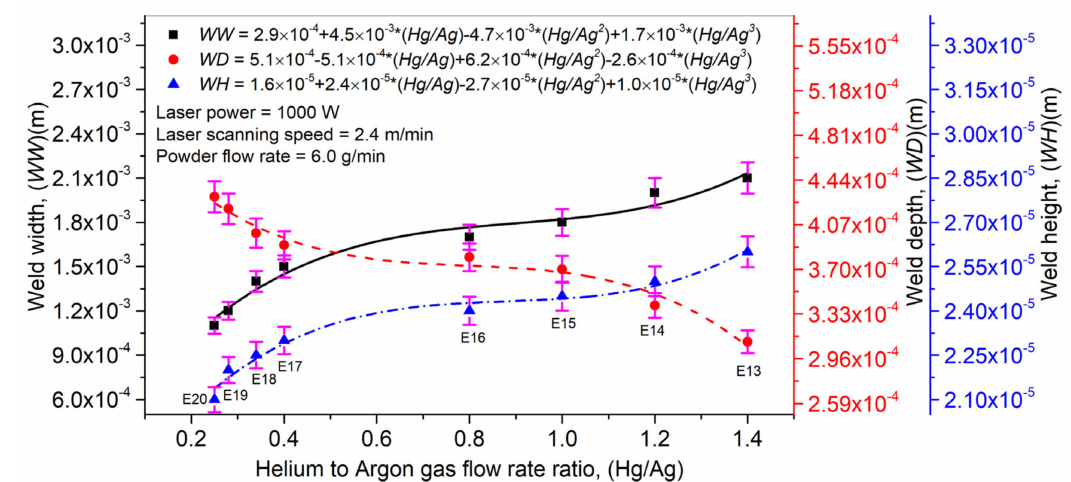
Figure 12. Effect of helium to argon gas flow rate ratio on laser weld width, depth, and height in laser welding with filler material (Inconel 718).